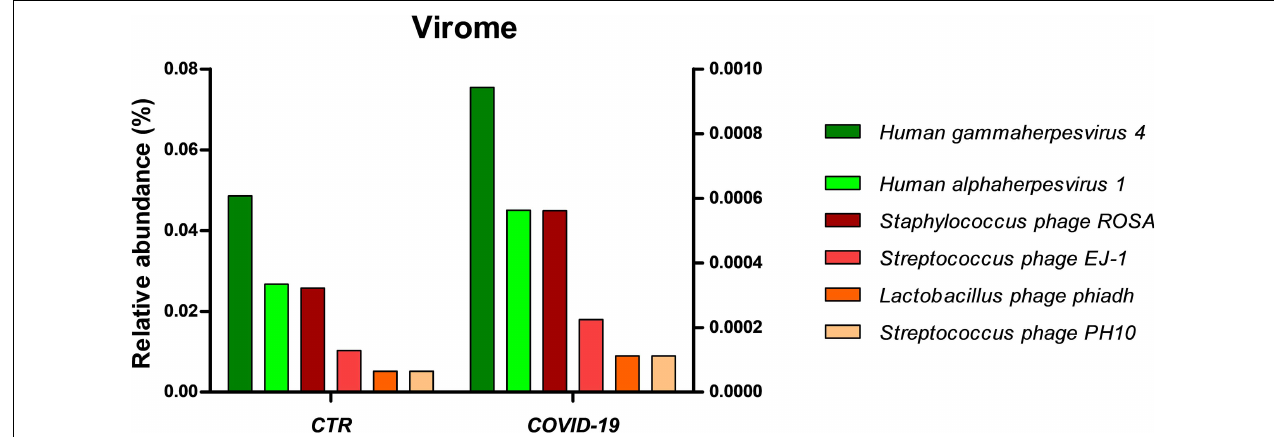
FIGURE 6 | Virome profile in the oral cavity of control (CTR) and COVID-19 subjects. The results are expressed as relative abundance (%). Left y axis refers to Human gammaherpesvirus 4 and Human alphaherpesvirus 1 (green bars), whereas right y axis refers to the amount of the four detected bacteriophage (orange-red bars).